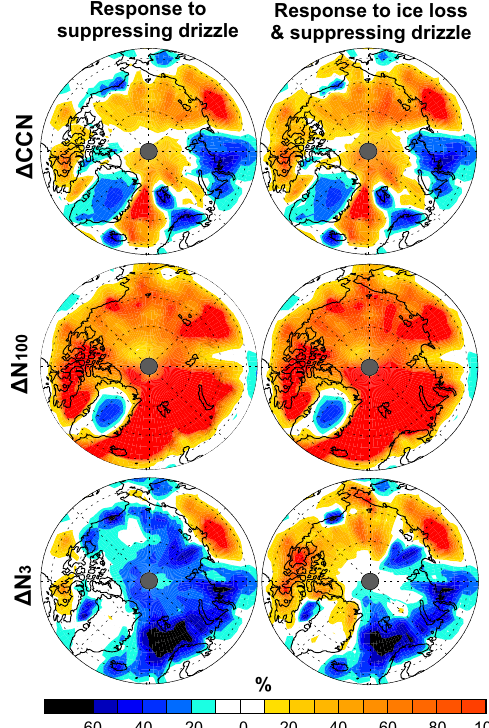
Figure 9. Response of modelled surface level aerosol concentra- Fig. 9. Response of modelled surface level aerosol concentrations due to suppression of drizzle (left tions due to suppression of drizzle (left column) and the combined column) and the combined effect of suppression of drizzle and loss of sea-ice (right column): CCN (top), effect of suppression of drizzle and loss of sea ice (right column): N 100 (middle) and N 3 (bottom). These simulations with sea-ice loss differ from those in figure 6 where CCN (top), N 100 (middle) and N 3 (bottom). These simulations with drizzle is switched off in all runs. Here, drizzle is switched off only when sea-ice is suppressed to represent sea-ice loss differ from those in Fig. 6 where drizzle is switched off a possible side effect of the enhanced aerosol sources on precipitation. in all runs. Here, drizzle is switched off only when sea ice is sup- pressed to represent a possible side effect of the enhanced aerosol sources on